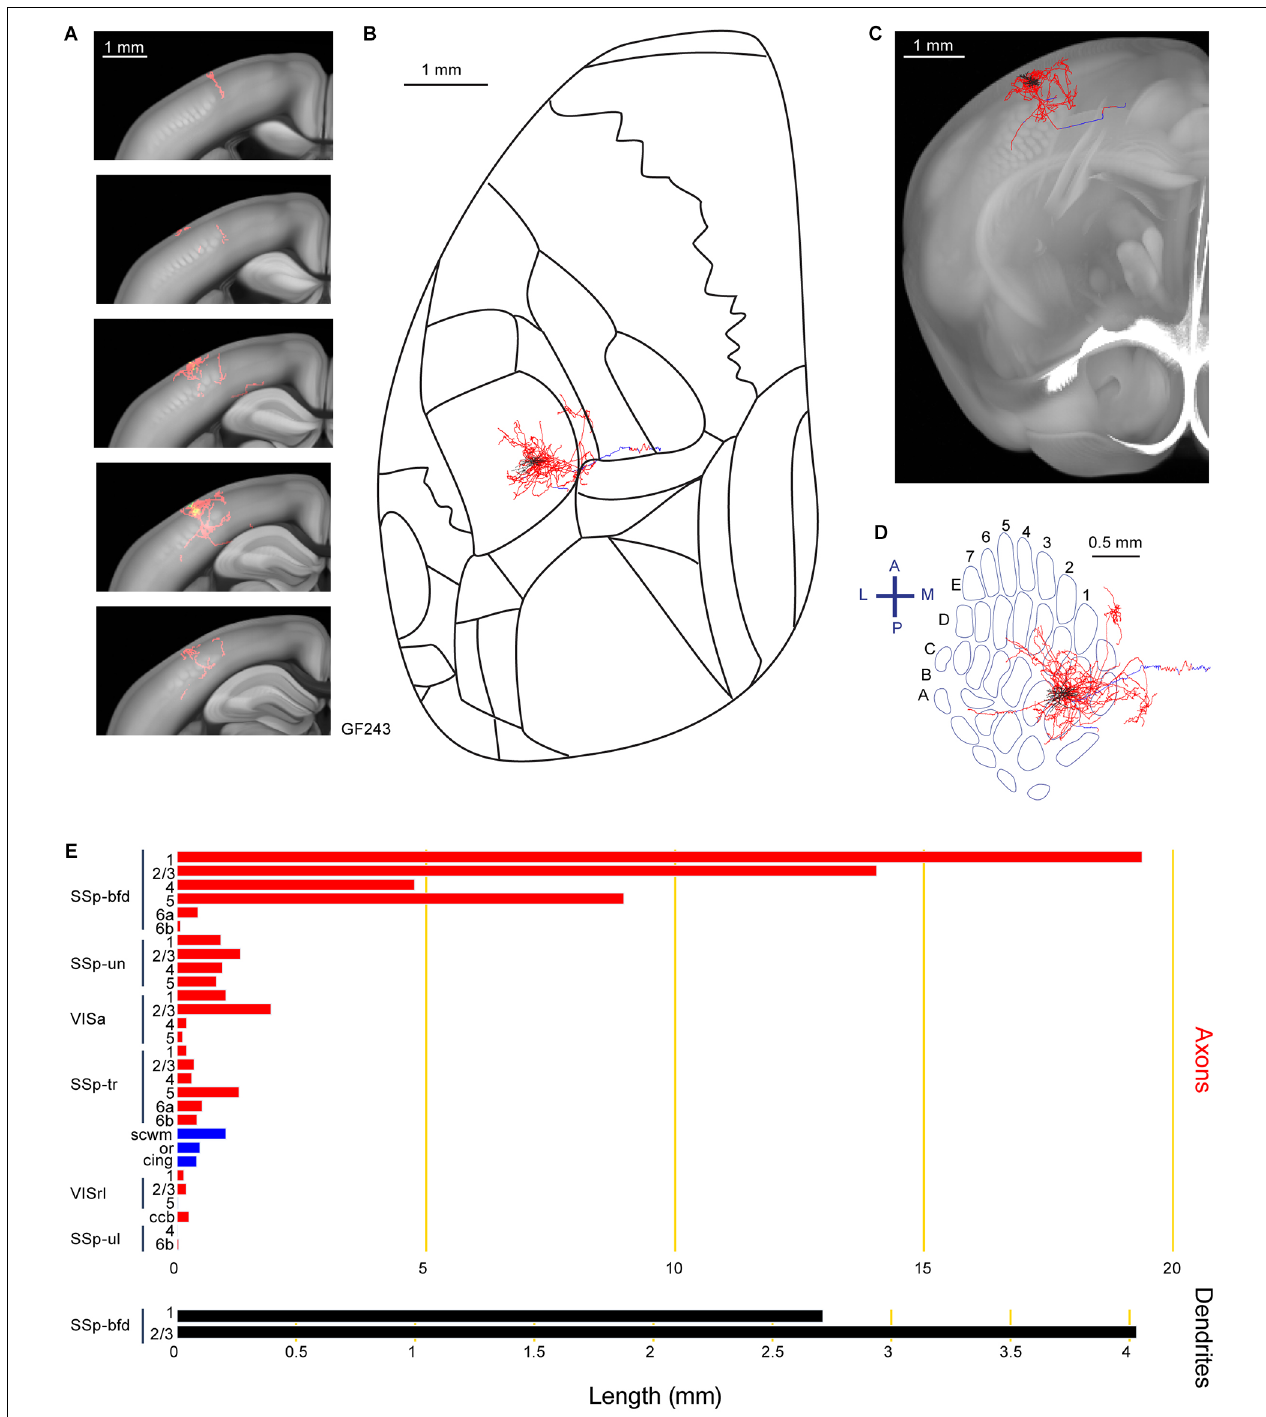
FIGURE 5 | Reconstruction and quantification of example neuron GF243 with projections to an unassigned region of the primary somatosensory cortex and an anterior visual area. (A) Serial overlays of axon (red) and dendrites (green) in coronal views encompassing the anterior-posterior span of the axons of 1.25 mm. Each section represents a maximum projection of 250 µ m. (B) Maximum projection of the reconstructed axon and dendrites in horizontal view. (C) Maximum projection of the axon and dendrites in coronal view. (D) Maximum projection of the axon and dendrites in tangential view (rotated 30 degrees) over the barrel field. The cell body is in the septa between the C1 and D1 barrel columns. (E) Quantification of axonal (top) and dendritic (bottom) length in respective brain regions identified by the Allen Mouse CCFv3. For (B) to (E) : dendrites are shown in black; axon in neocortical gray matter is shown in red; axon in white matter is shown in blue.